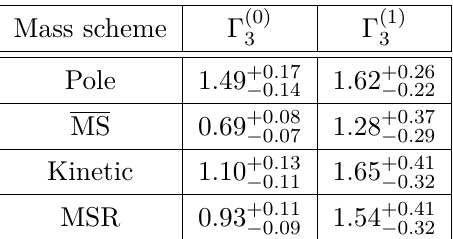
; see table 5 for the values of s